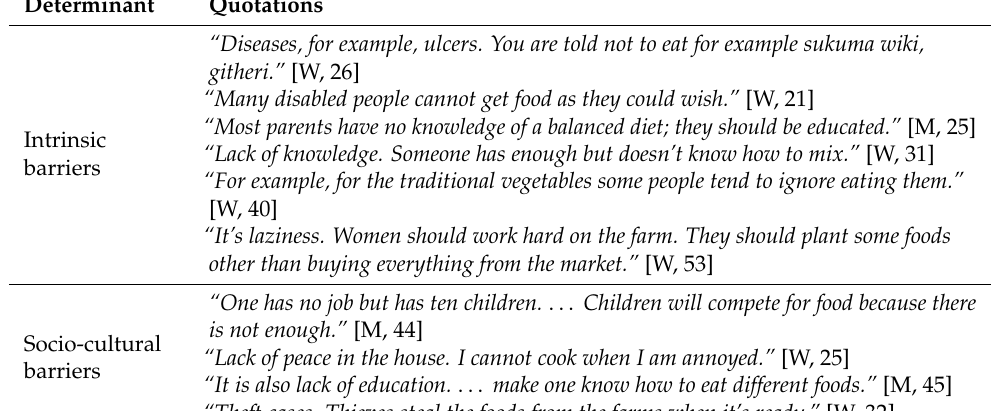
Table 6. Individual determinants of healthy eating and quotations from participants of Focus Group Discussions in Vihiga County,